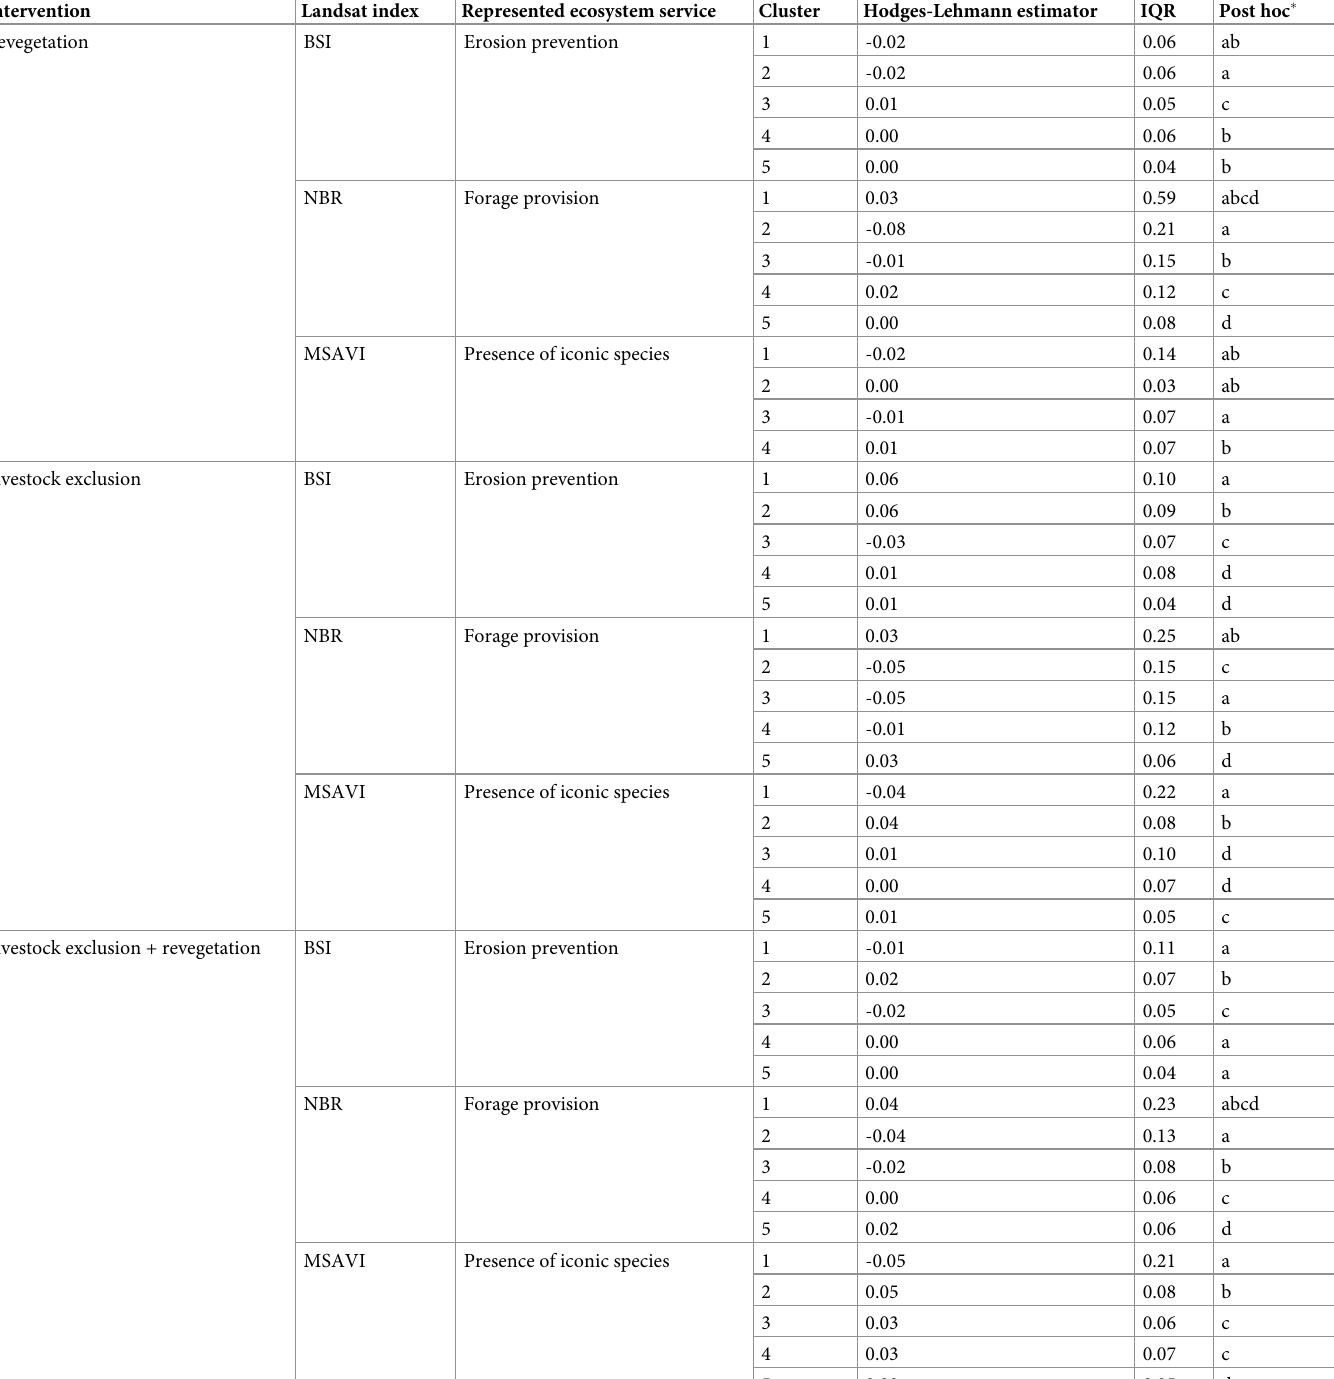
Table 7. Comparison of BACI contrast between vegetation clusters indicating the state of the vegetation for each intervention and ecosystem service using the Krus- kal-Wallis test (Games-Howell post-hoc).